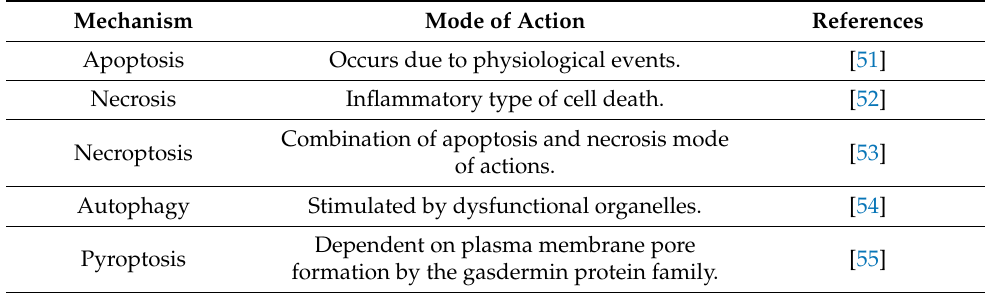
Table 2. Cell death mechanisms according to the Nomenclature Committee on Cell